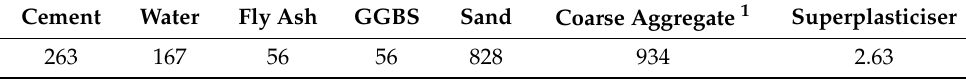
Table 3. Mix composition of ready-mixed concrete (unit: kg/m 3 ).